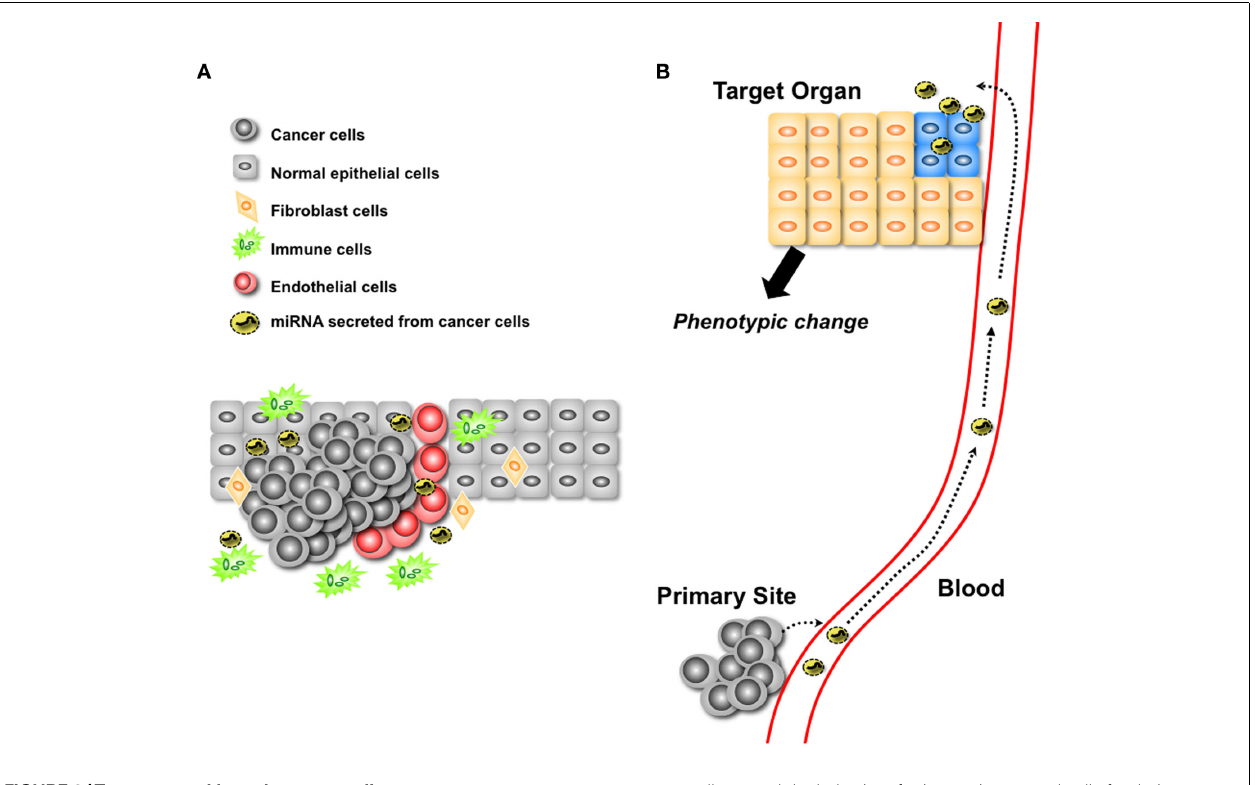
FIGURE 2 |Two proposed hypotheses regarding secretory miRNA-mediated cancer progression. (A) Secretory miRNAs mediate the modulation of microenvironmental cells. Secretory miRNAs from